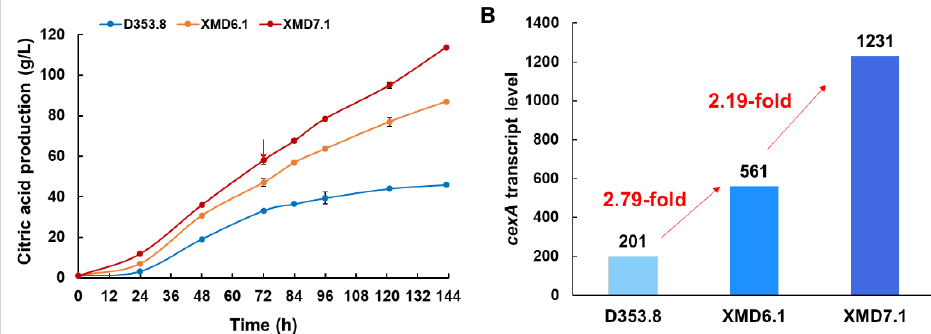
Figure 5. Transcription analysis of cexA -expressing constructs in submerged citric acid fermentation. Citric acid production ( A ) and the cexA transcript level ( B ) of the cexA- expressing constructs in 5 L bioreactors. Then, 1 × 10 5 spores/mL were inoculated in submerged citric acid fermentation at 34 °C for 144 h. The extracellular citric acid was determined by the method of HPLC. Results are the mean of three replicates, and error bars indicate standard deviations ( n = 3). The red arrow in ( A ) represents the time point of sampling for RNAseq analysis.